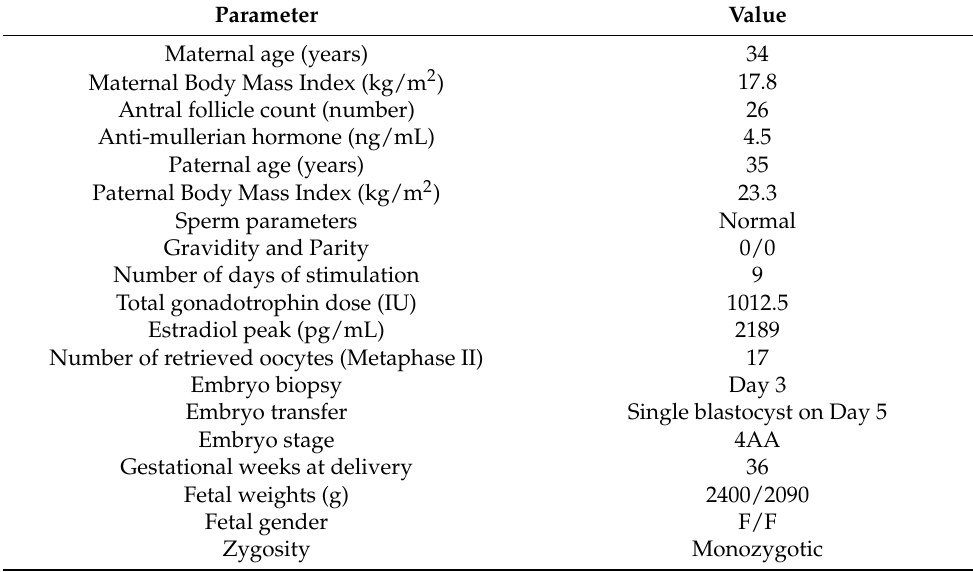
Table 1. Clinical and biological parameters associated with dichorionic diamniotic twin